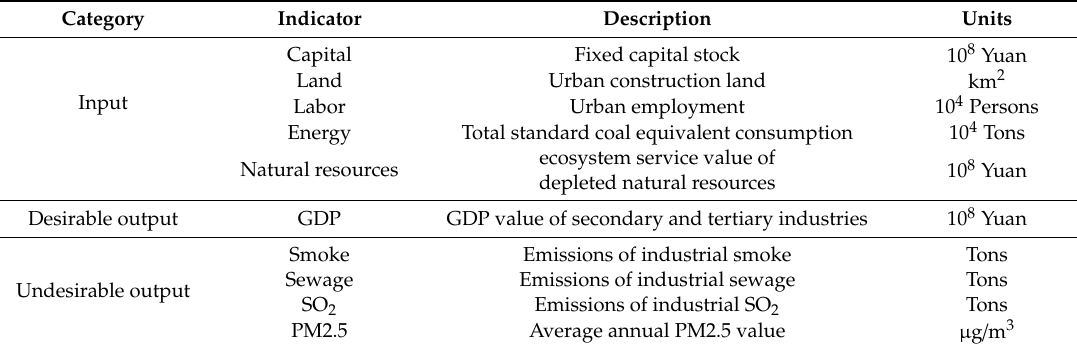
Table 1. Input and output